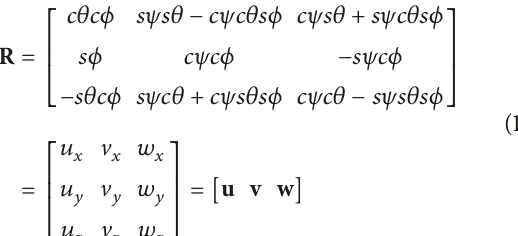
Figure 3: Twist system of the RPU